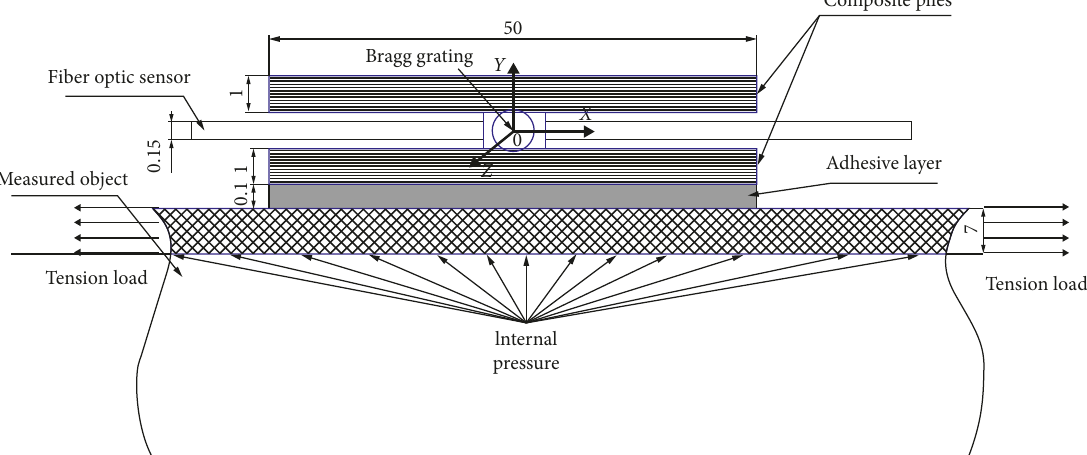
Figure 2: Model scheme for calculation of strains transferred from the measured surface through the composite plies and adhesive layer to FBG.